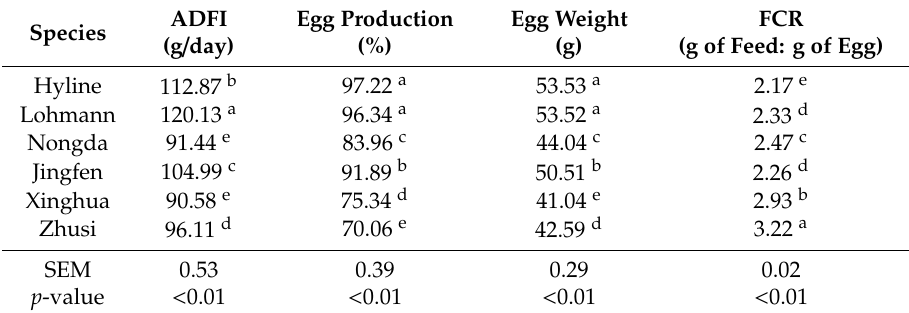
Table 2. Body weights and productive performance of laying hens ( n = 5).